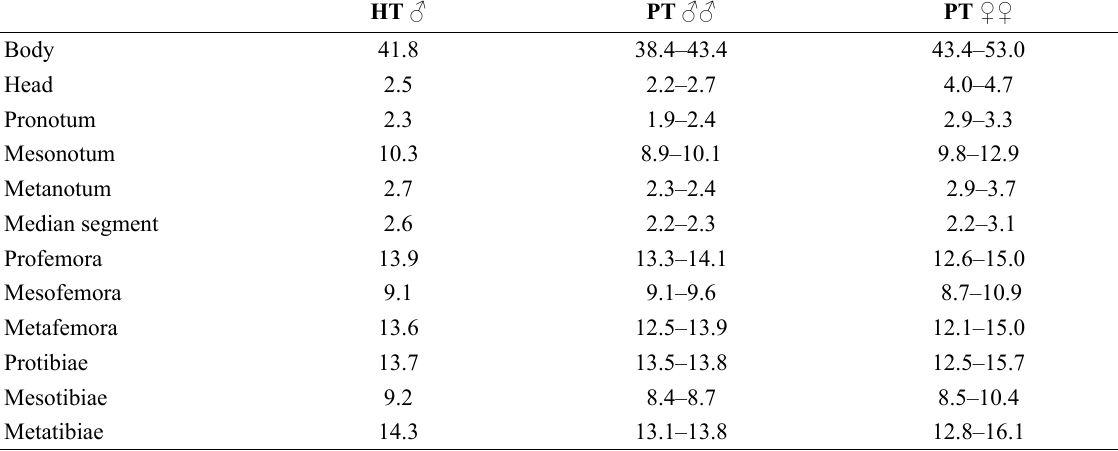
Table 1. Measurements (mm) of Otraleus applai sp. nov. HT = holotype; PT =